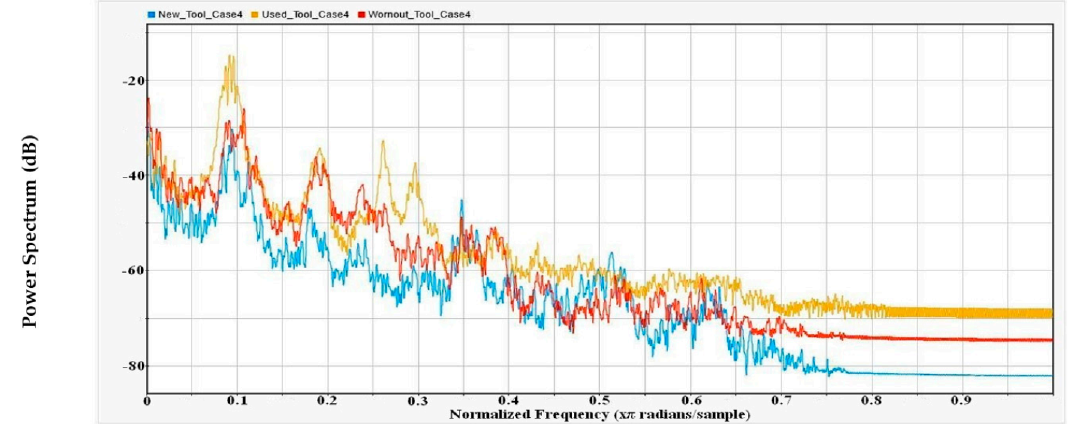
Figure 19. Power spectral density (PSD) for Case-4 of new (blue), used (yellow), and worn-out (red) tool with maximum leakage